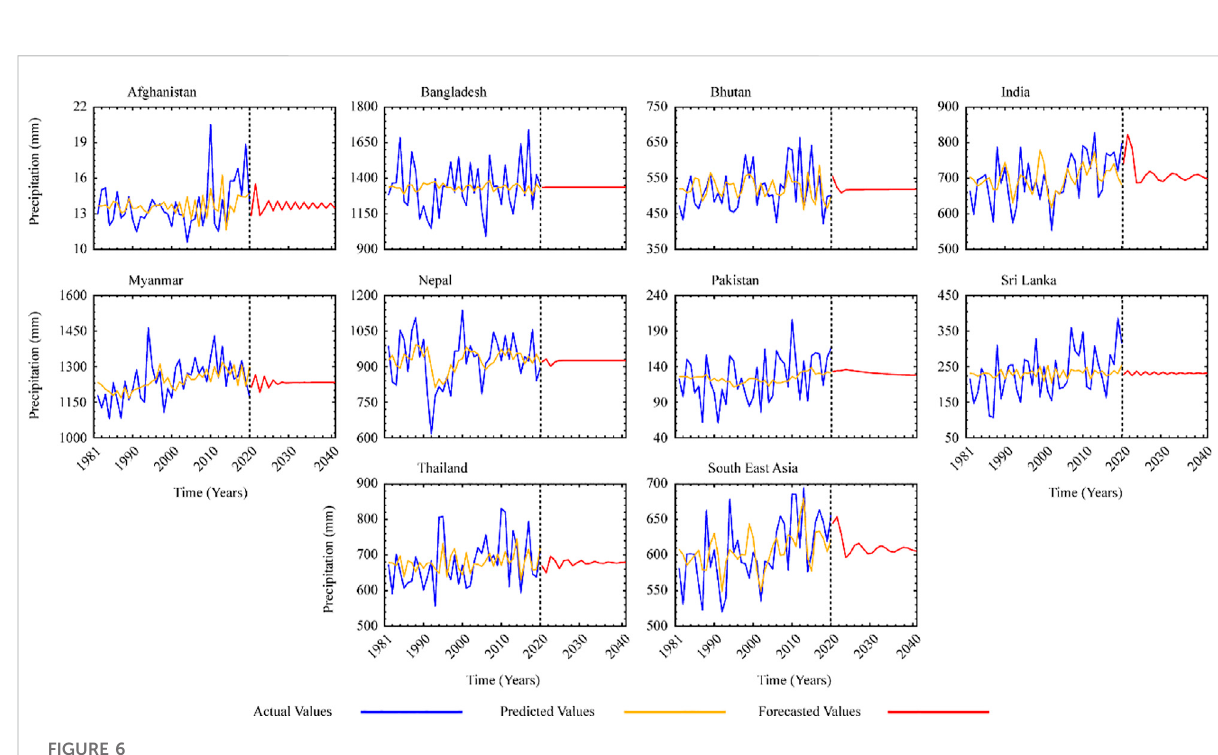
FIGURE 6 ARIMA Forecasting for time series summer mean precipitation for the study